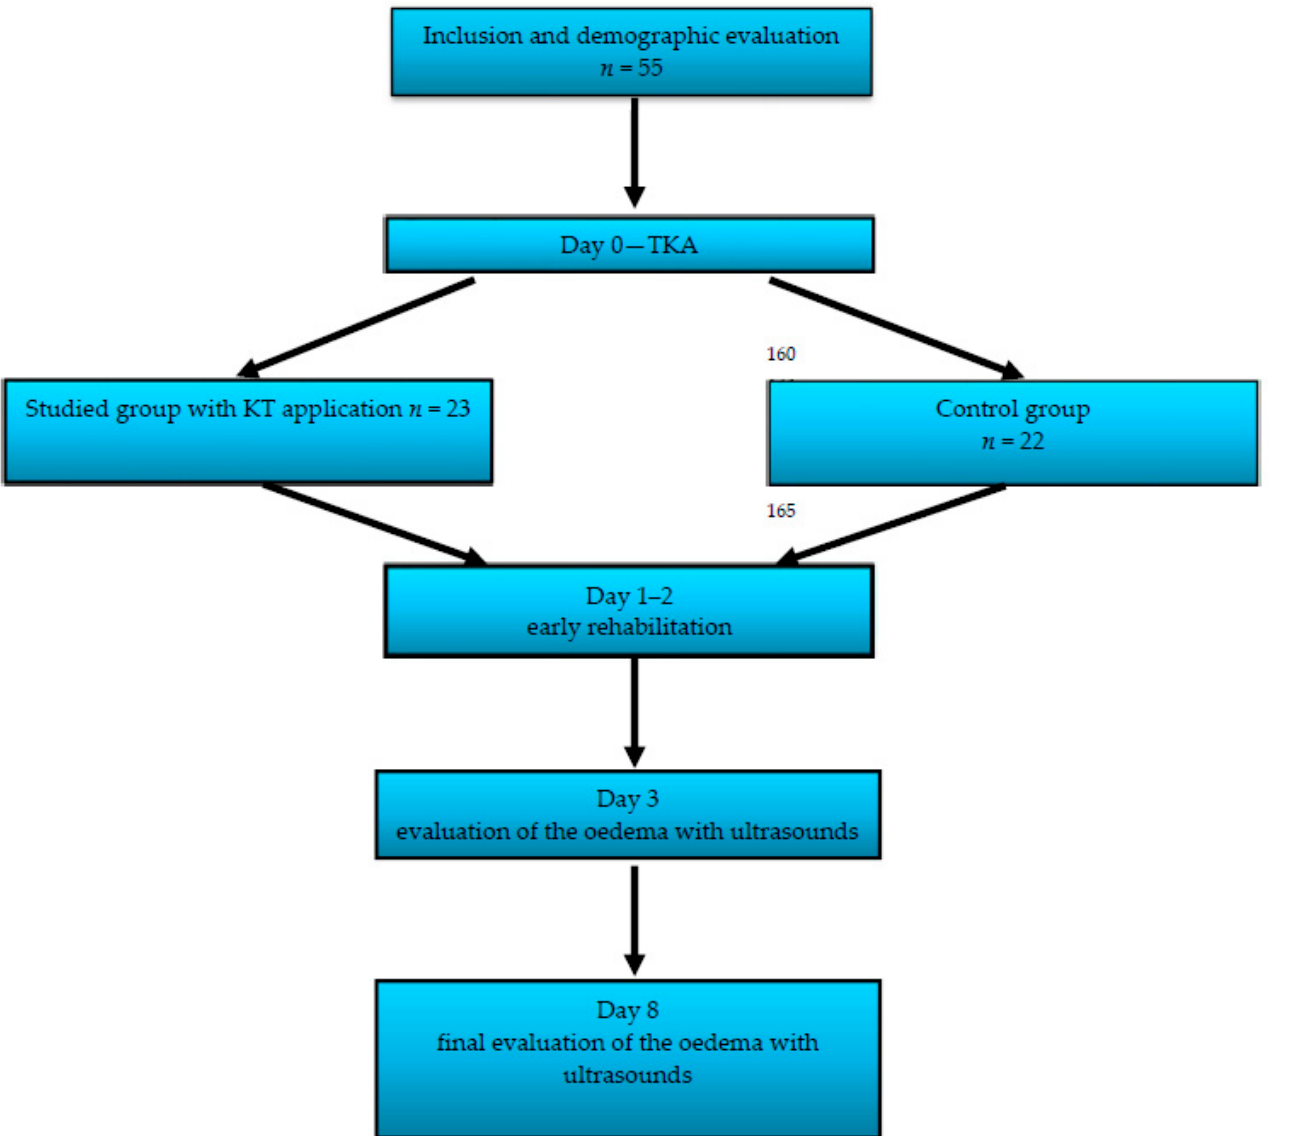
Figure 5. Flowchart of the study design.